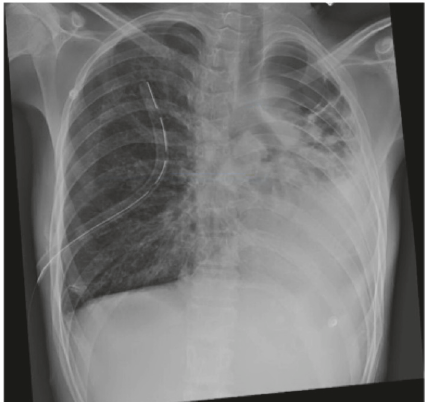
Figure 6: Chest X-ray after insertion of a new chest tube and resolution of the right-sided